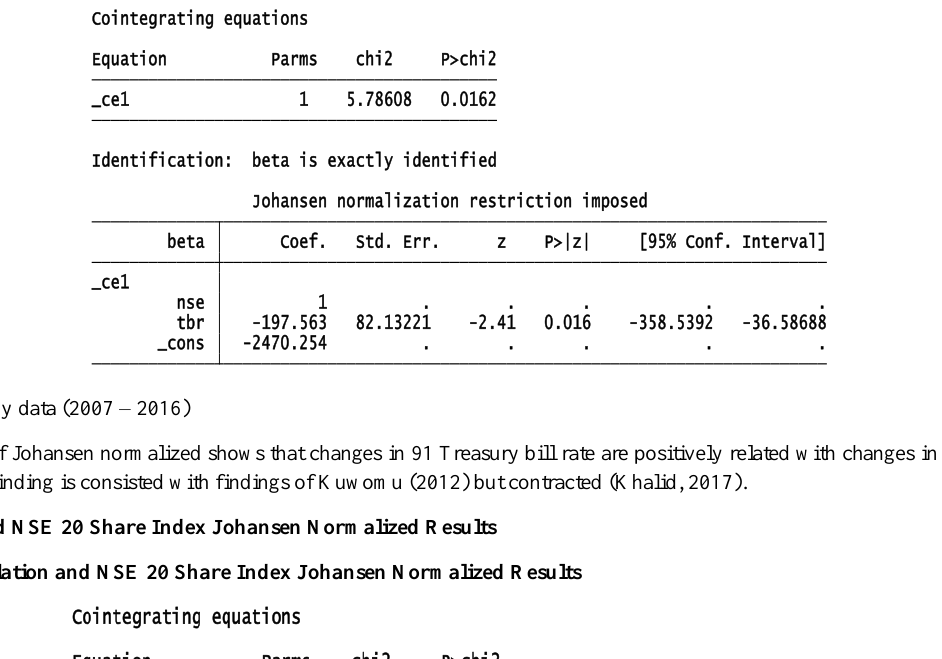
Table 3: 91 Treasury Bill Rate and NSE 20 share Index Johansen Normalized Results